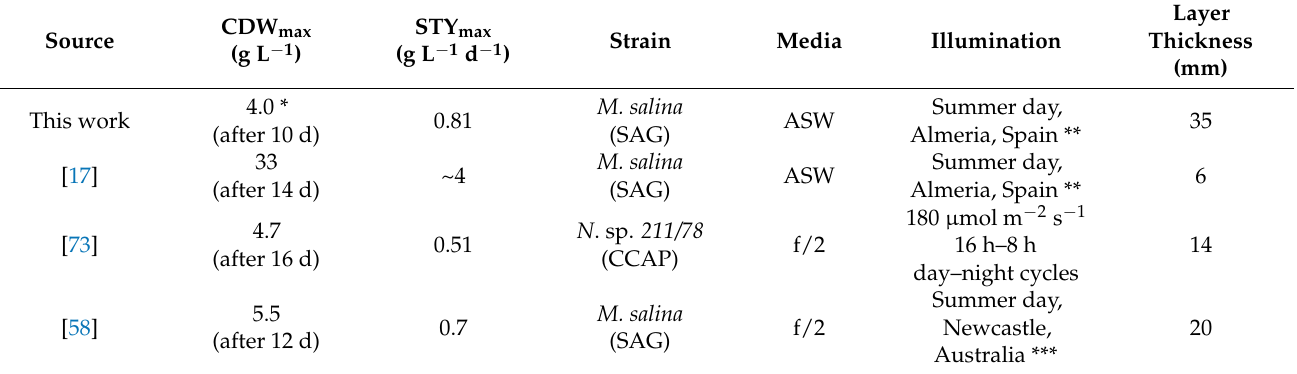
Figure 9. Automated photoautotrophic batch cultivation of M. salina in miniaturized stirred-tank PBRs with day and night cycles imitating typical Mediterranean climate conditions (repeated summer day in Almeria, Spain, recorded by DLR at Plataforma Solar de Almería on 15 June 2012, courtesy of S. Wilbert). One row of eight stirred PBRs in the bioreaction unit was illuminated at 66% ( left ), and the second row at 100% light intensity ( right ). The gray shading indicates the dynamic incident light intensity variations applied. The temperature of all parallel PBRs was adjusted hourly to follow the climate data. Each bioreactor was initially filled with 10 mL of M. salina suspension in an ASW medium with an initial OD 750 of 0.5 (initial pH 8 + 0.3). Magnetically induced S-stirrers were employed at 500 rpm. The head space of the 48 parallel stirred-tank bioreactors was rinsed with 288 L h − 1 of sterile air with 2% CO 2 . Sampling was performed at physically simulated sunrise and sunset times. Table 2. Maximum volumetric productivities (STY max ) and maximum dry cell weight (CDW max ) concentrations reported for M. salina in photoautotrophic batch cultivations with day and night cycles. ues of 8.96 ± 0.84 (100% illumination) and 9.89 +/ − 0.68 (66% illumination), respectively, CDW Source